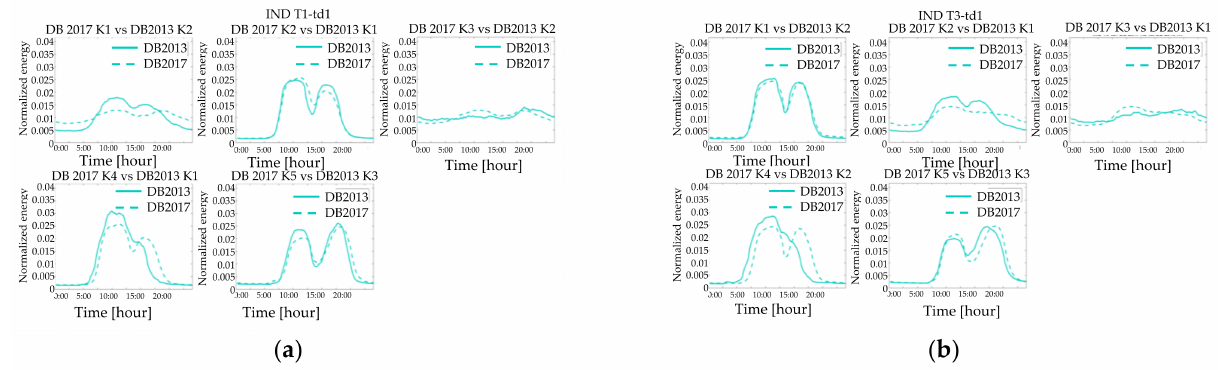
Figure 13. Industrial (IND) end-users, comparison between normalized centroids of the two databases (DB2013 vs. DB2017): ( a ) winter workdays, ( b ) summer